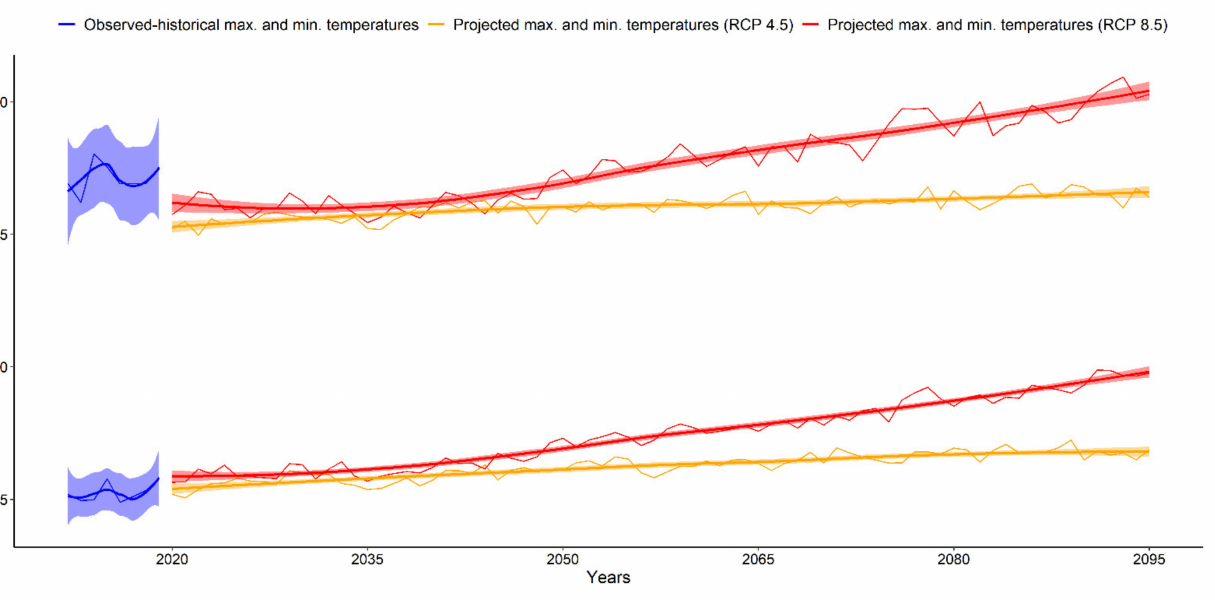
Figure 4. Mean daily maximum and minimum temperatures for the observed historical climate condition and the two climate change projections corresponding to RCPs 4.5 and 8.5. The shaded area shows the 95% confidence interval enclosing the linear trendline estimated for the temperature